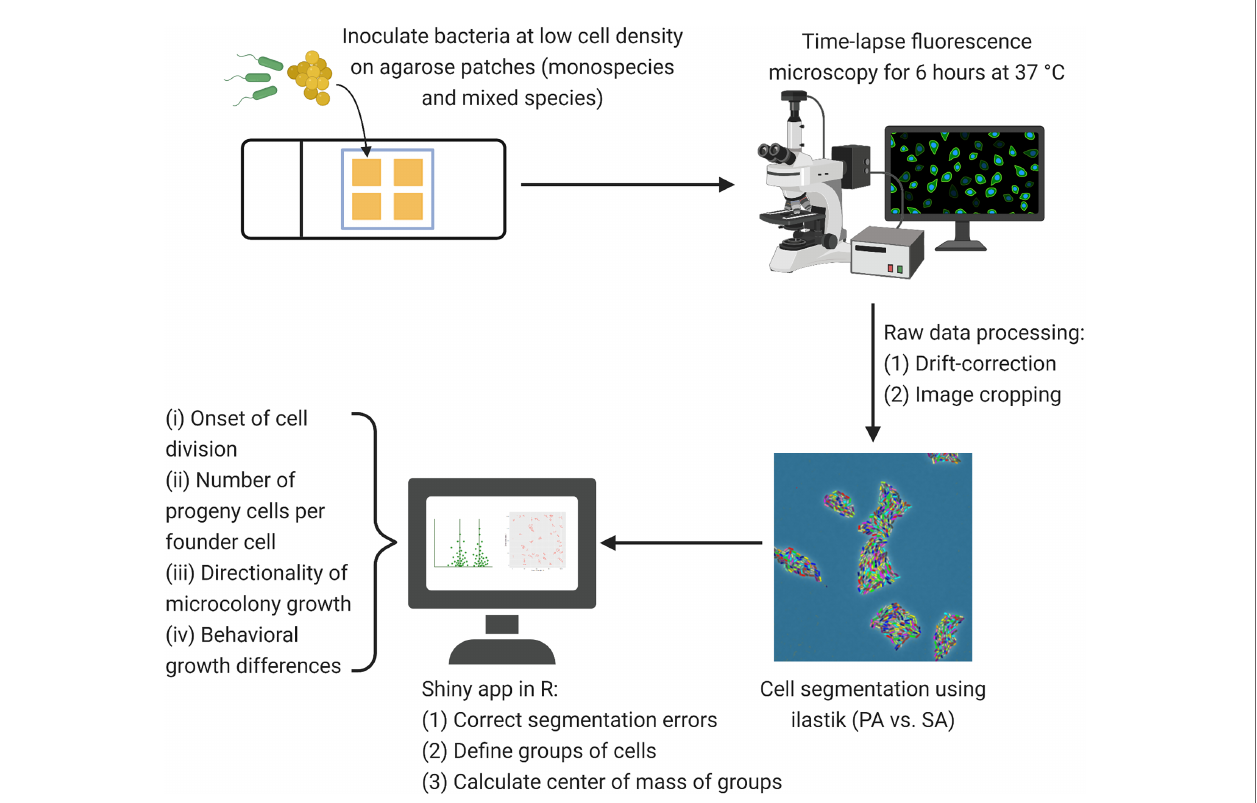
FIGURE 1 | Microscopy work fl ow for time-lapse fl uorescence microscopy. After adjusting P. aeruginosa (PA) and S. aureus (SA) to similar cell numbers, we inoculated bacteria (each species alone or mixed 1:1) at low cell density on TSB + 1% agarose patches. Time-lapse fl uorescence microscopy was carried out for six hours at 37°C with pictures taken every ten minutes. We drift-corrected and cropped the time-lapse images before cell segmentation (PA vs . SA) in ilastik (version 1.3.2). Using a Shiny app in R, we corrected segmentation errors from the exported object predictions, de fi ned groups of cells and extracted the center of mass per group of cells for each timepoint. We then calculated the onset of growth (time to fi rst cell division per microcolony), the number of progenies per founder cell in a microcolony, and the directionality of microcolony growth using automated scripts in R. Distinct microcolony interaction patterns between the species were manually assessed and